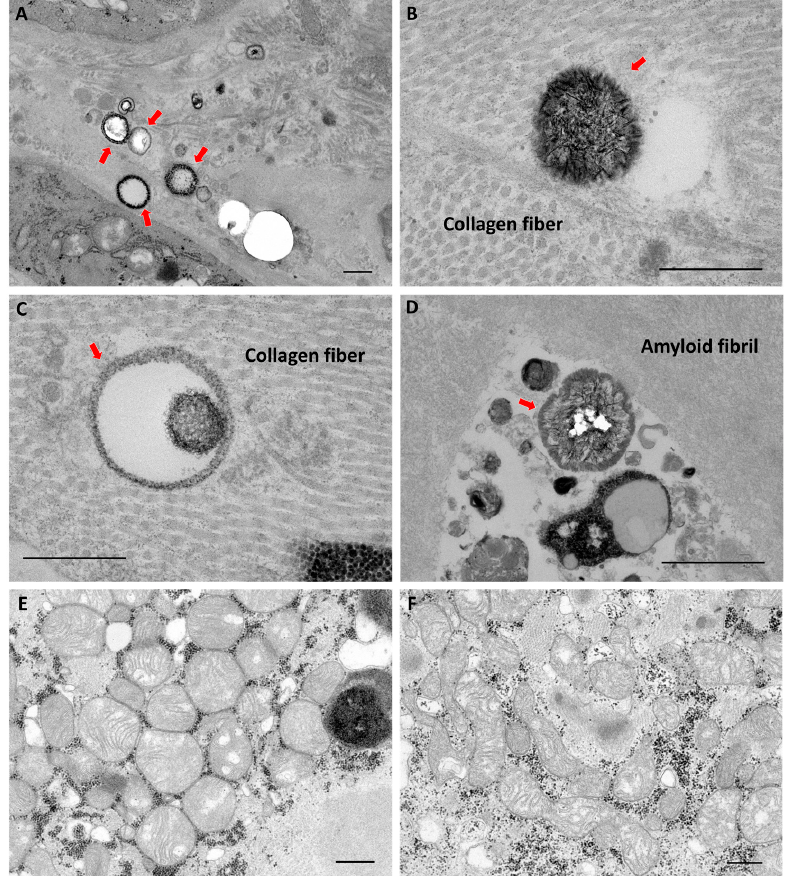
Figure 3. Transmission electron microscopy findings using the myocardial tissue from a patient with transthyretin cardiac amyloidosis. ( A – D ) Red arrows indicate calcified microparticles. ( E , F )